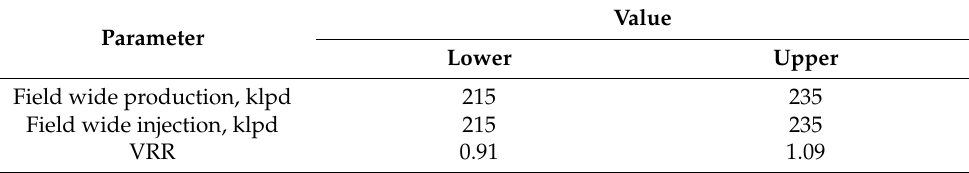
Table 4. Field constraints imposed during waterflood forward modelling. The rates are in kiloliters per day